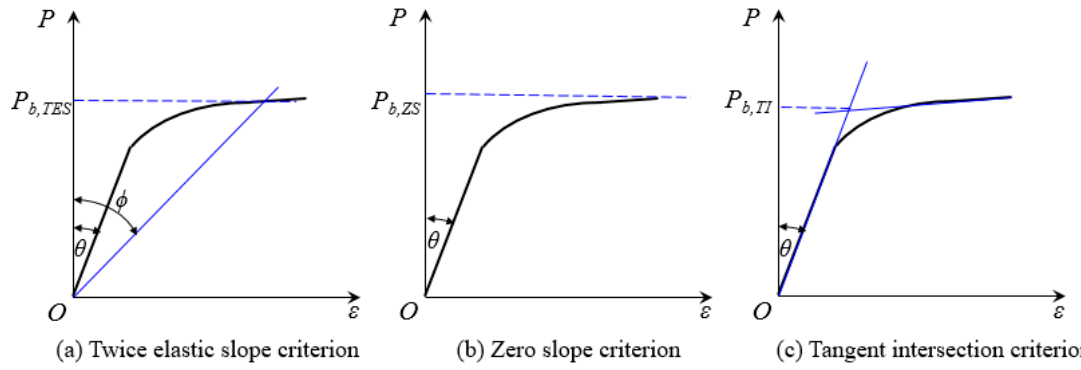
Figure 12. Criteria for the pipe burst pressure.